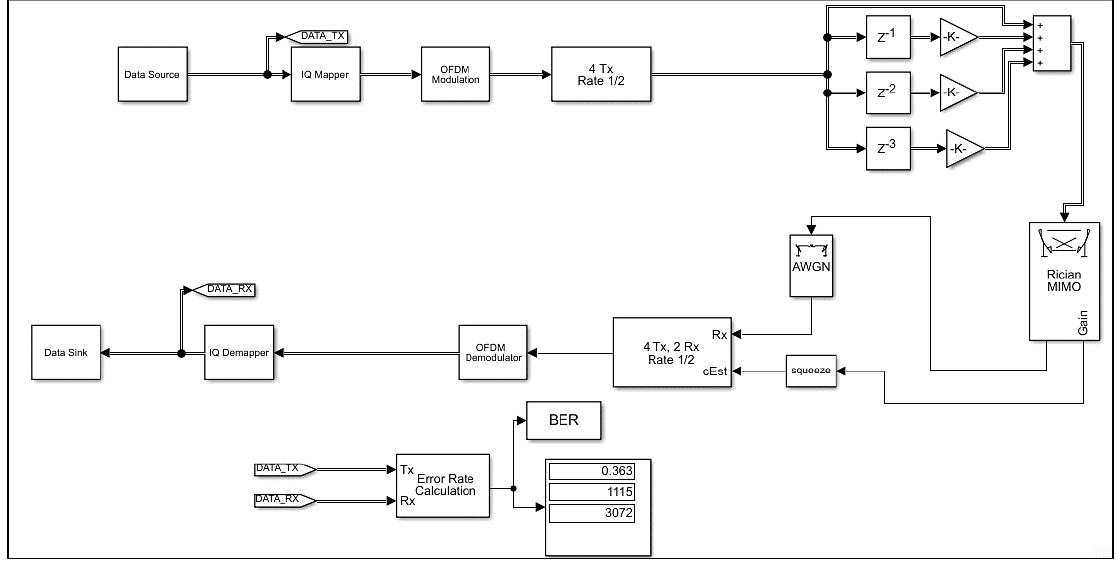
Figure 7. CDMA-MIMO-OFDM Model in Rician Channel.